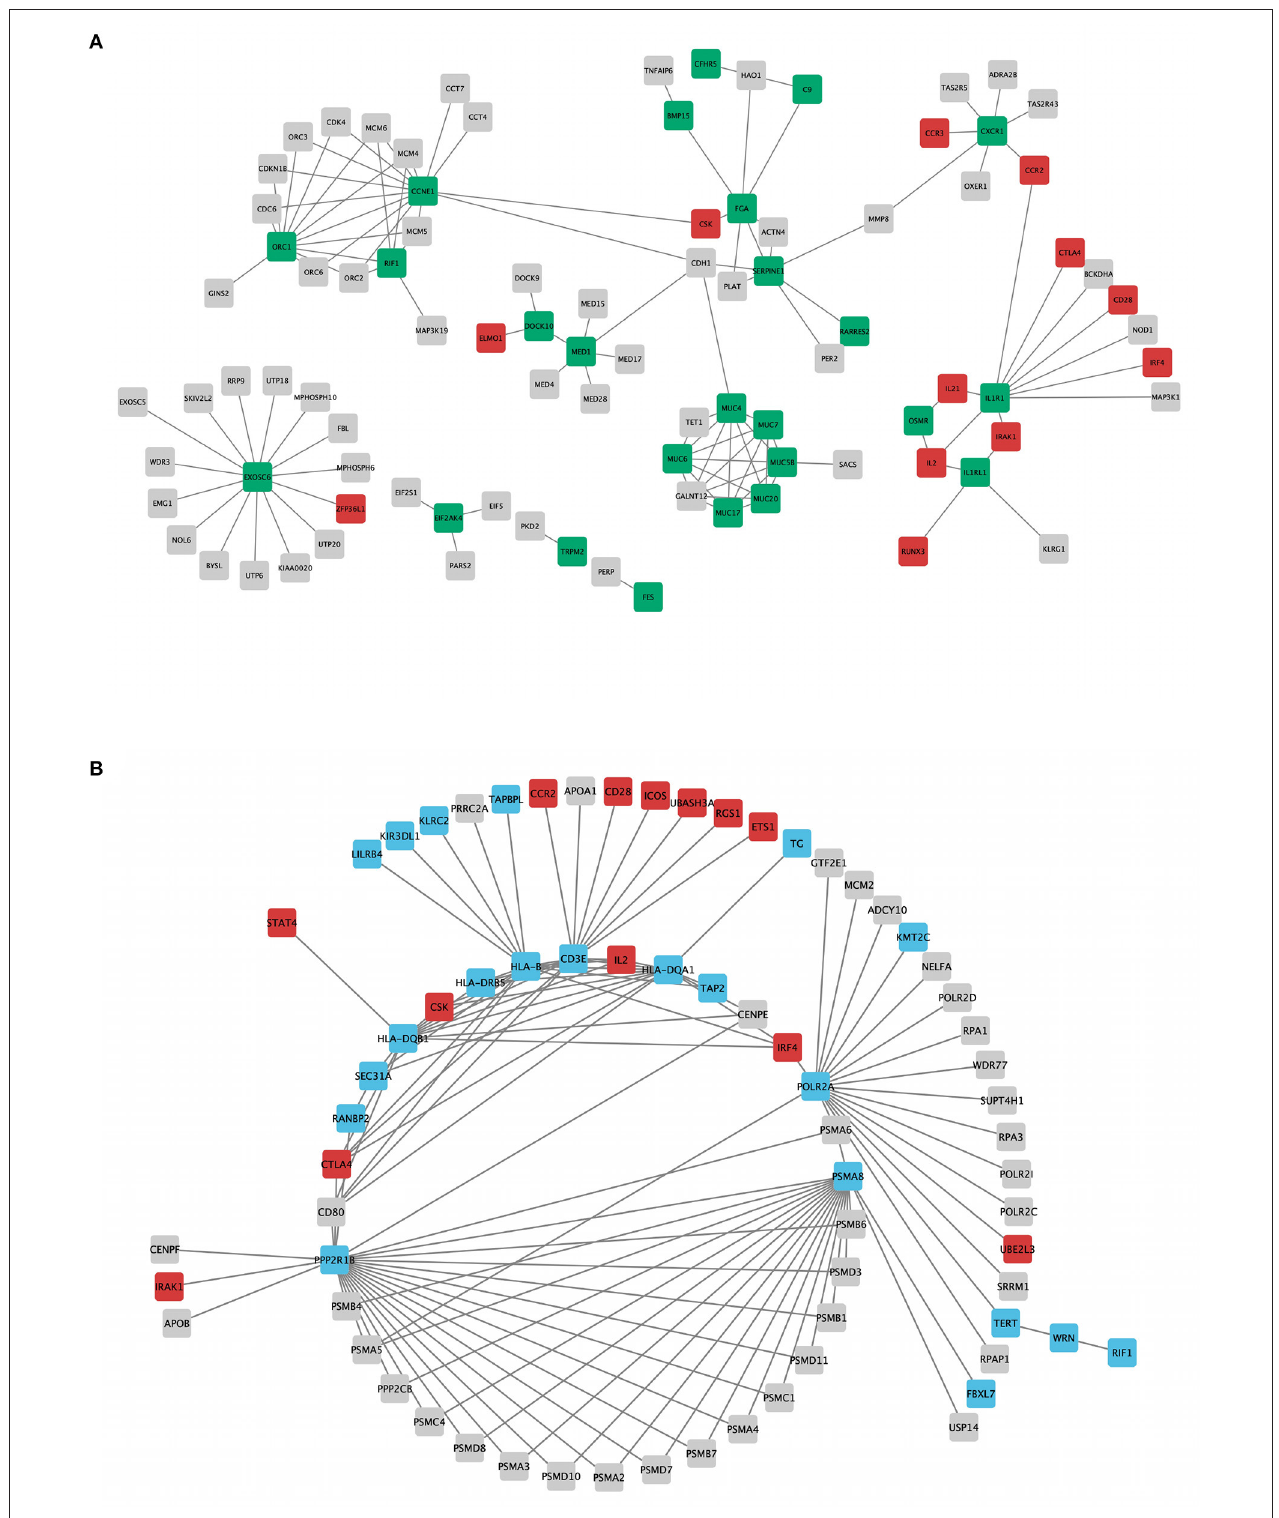
FIGURE 3 | Rare variant mapped genes and genome-wide association study (GWAS) locus gene protein interaction sub-networks of families A (A) and B (B) . Green (family A) and blue (family B) nodes represent whole-exome sequencing (WES)-identified genes, while red nodes represent GWAS-identified loci with r 2 > 0.8, visualized using Cytoscape 3.8.2